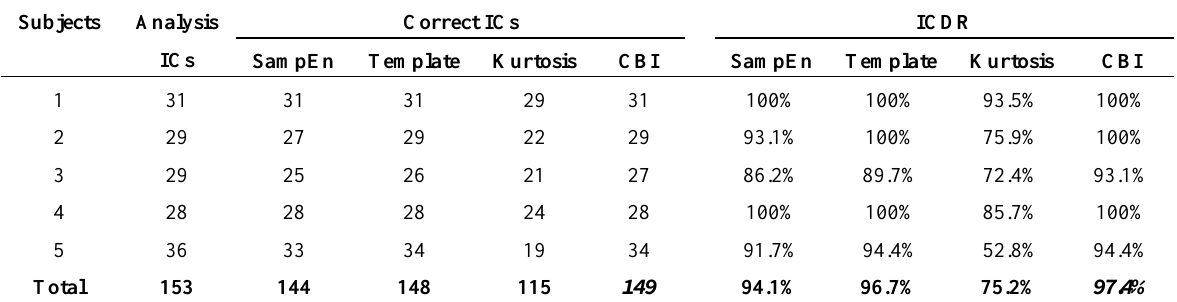
Table 1. The comparison result of four methods on the first dataset with Condition